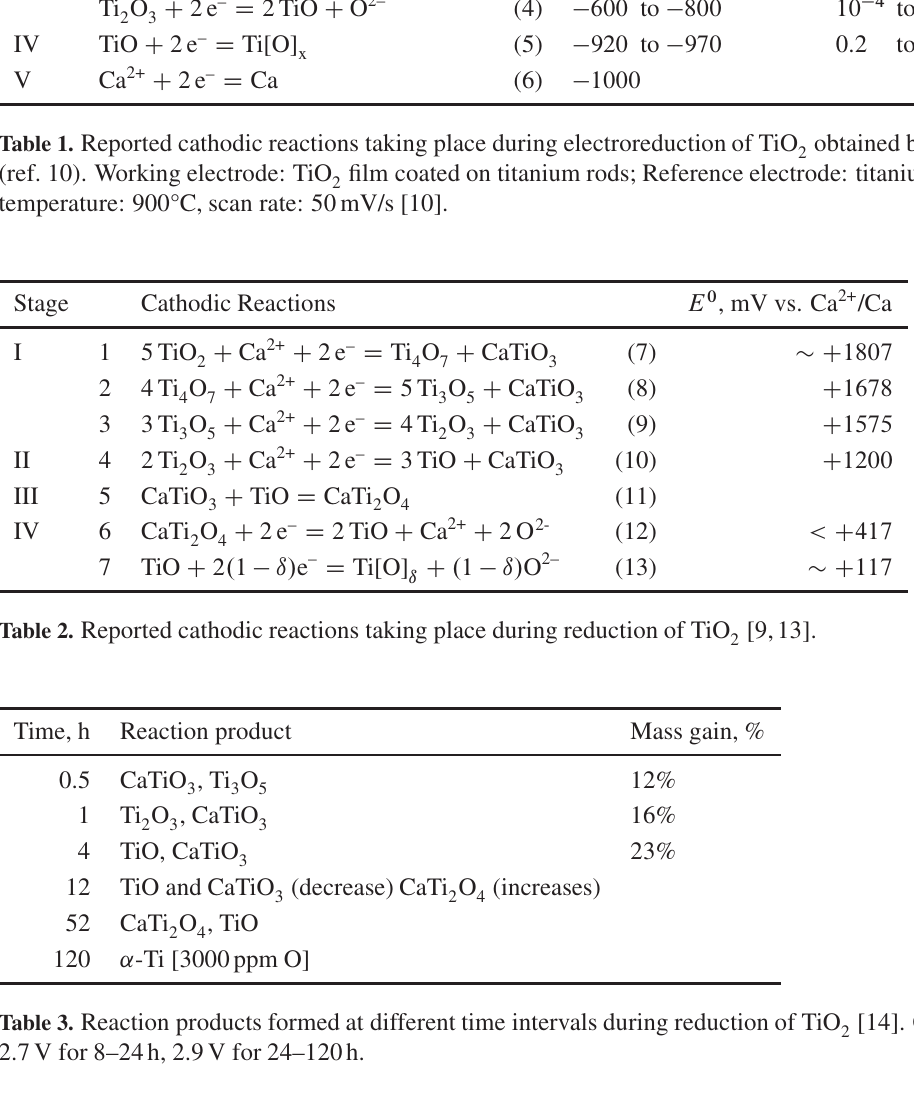
Table 3. Reaction products formed at different time intervals during reduction of TiO 2.7 V for 8–24h, 2.9 V for